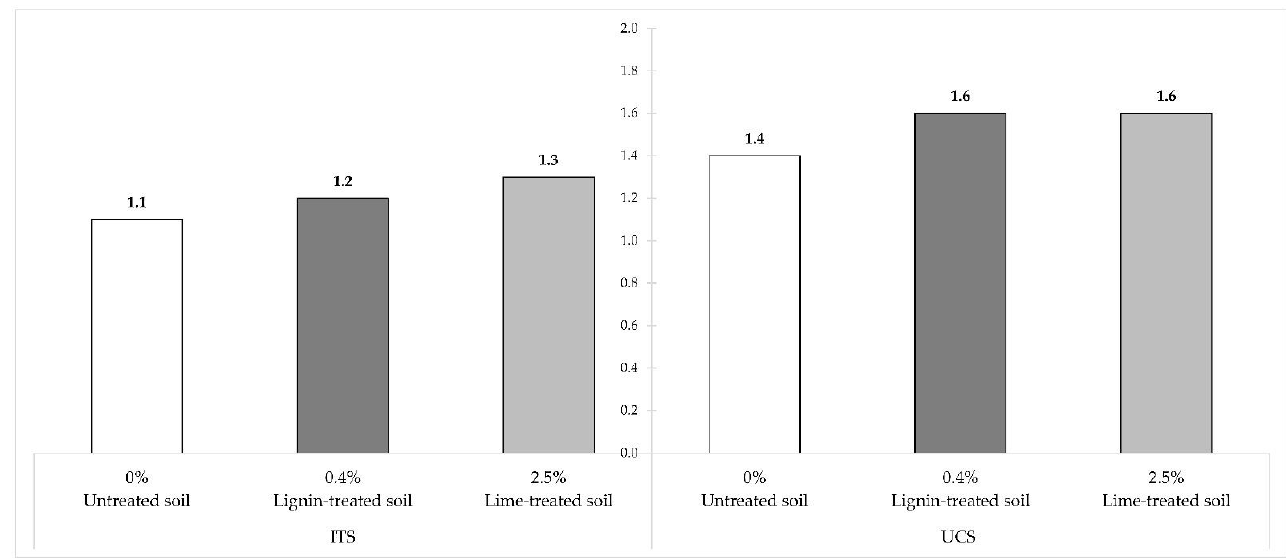
Figure 8. Comparison between the results of the ITS (daN/cm 2 ) and UCS (N/mm 2 ) tests carried out on the untreated soil, the lignin-treated soil, and the soil treated with lime.